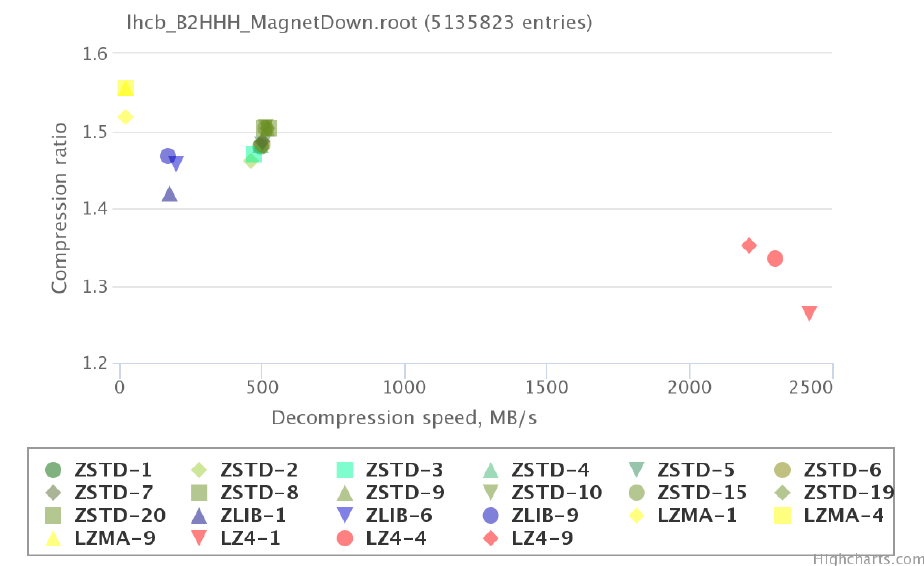
Figure 2. Comparison of compression ratio and decompression speed for all compression algorithms for NanoAOD 2019 file.